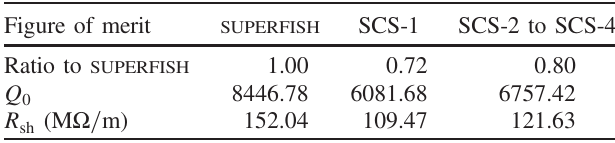
FIG. 9. Accelerating voltage and beam current in the SCSs given by Eq. (6).